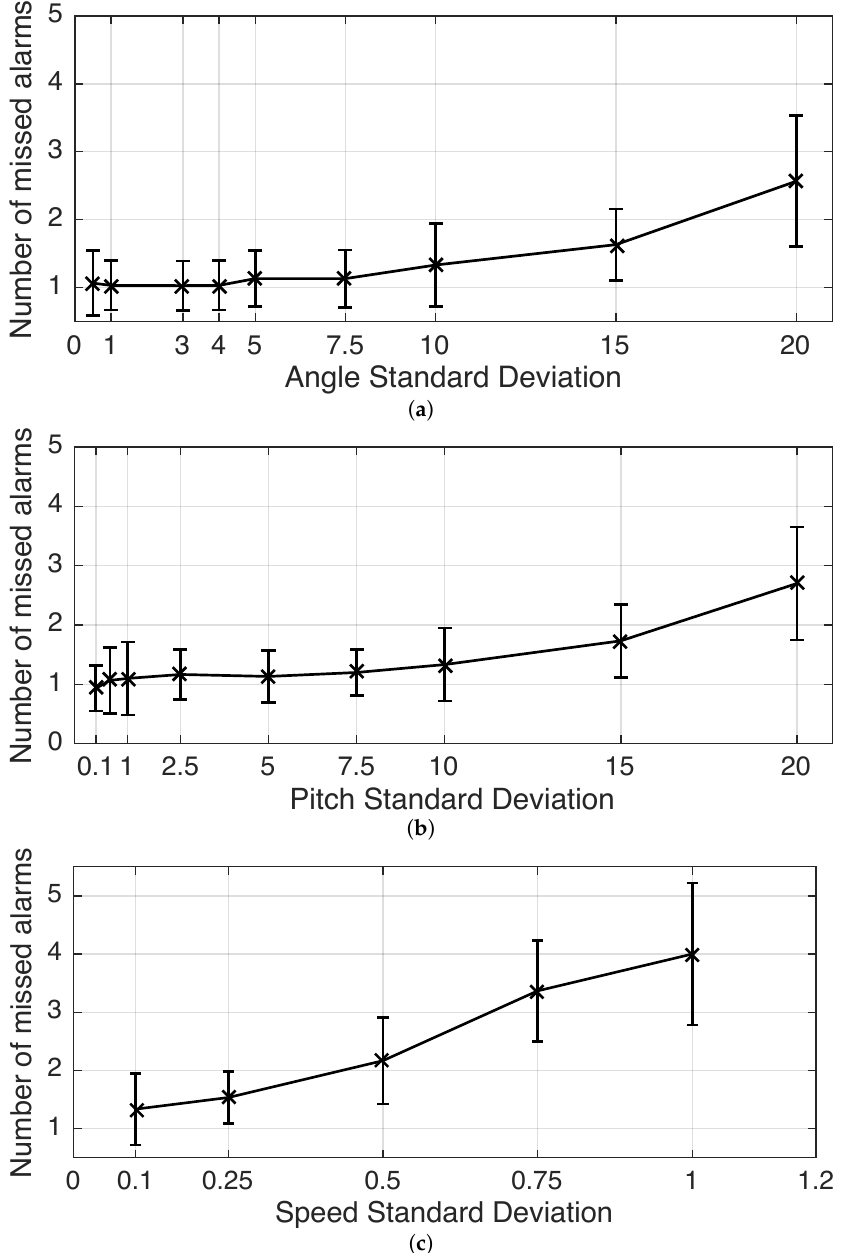
Figure 15. Impact of the standard deviation on the number of missed alarms: ( a ) angle SD; ( b ) pitch SD; ( c ) speed